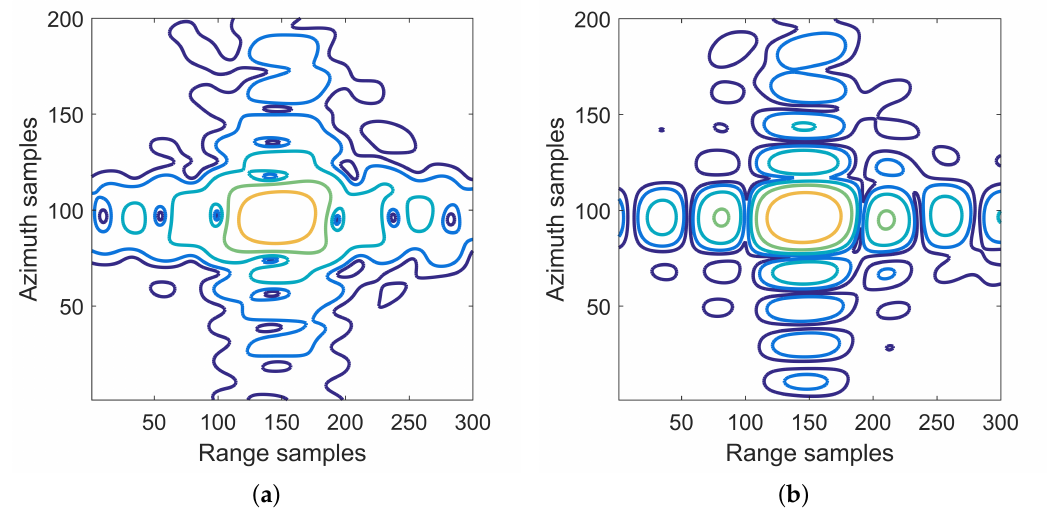
Figure 14. The imaging result of point target based on ( a ) start-stop model and ( b ) non-start-stop